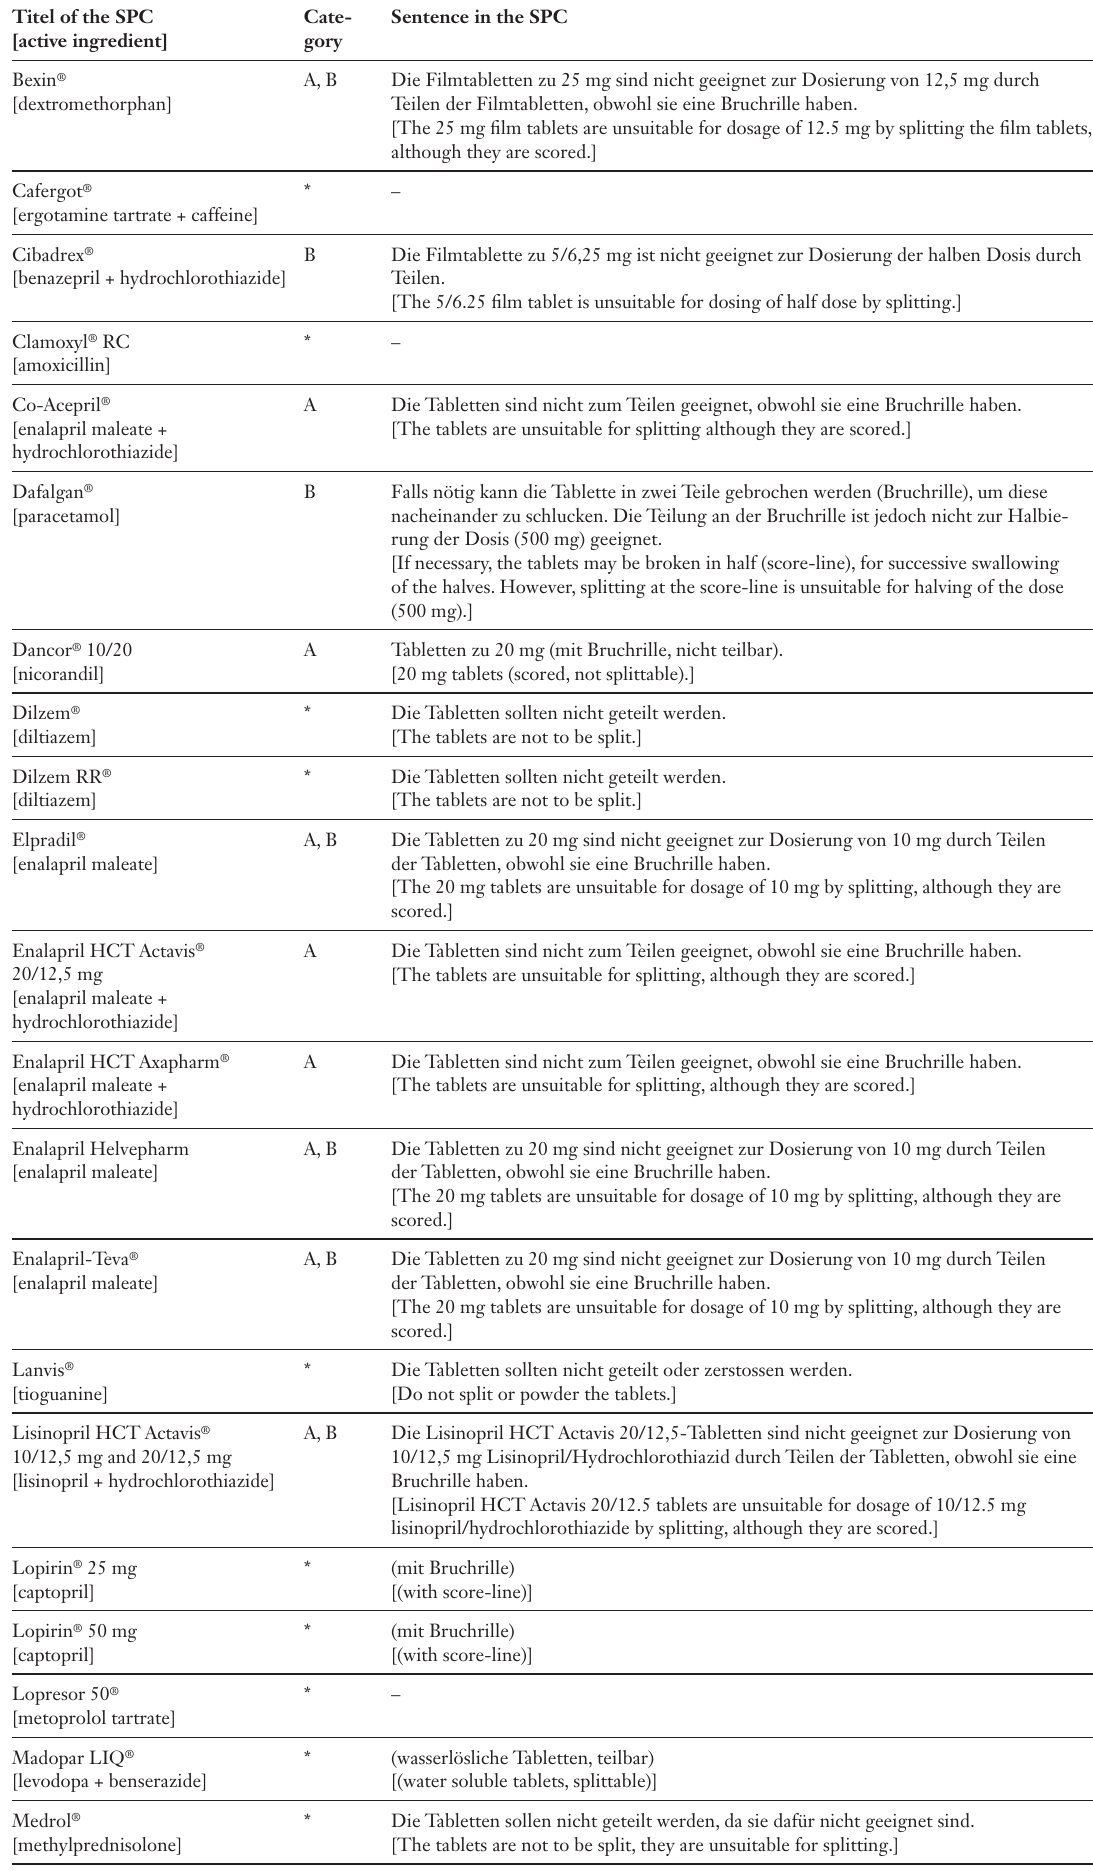
Table 1 Tablets with decorative score- lines according to manufacturers’ answers (*) and to the sentences (in German) forbidding a fractional dosing in the SPCs, with wording grouped in categories